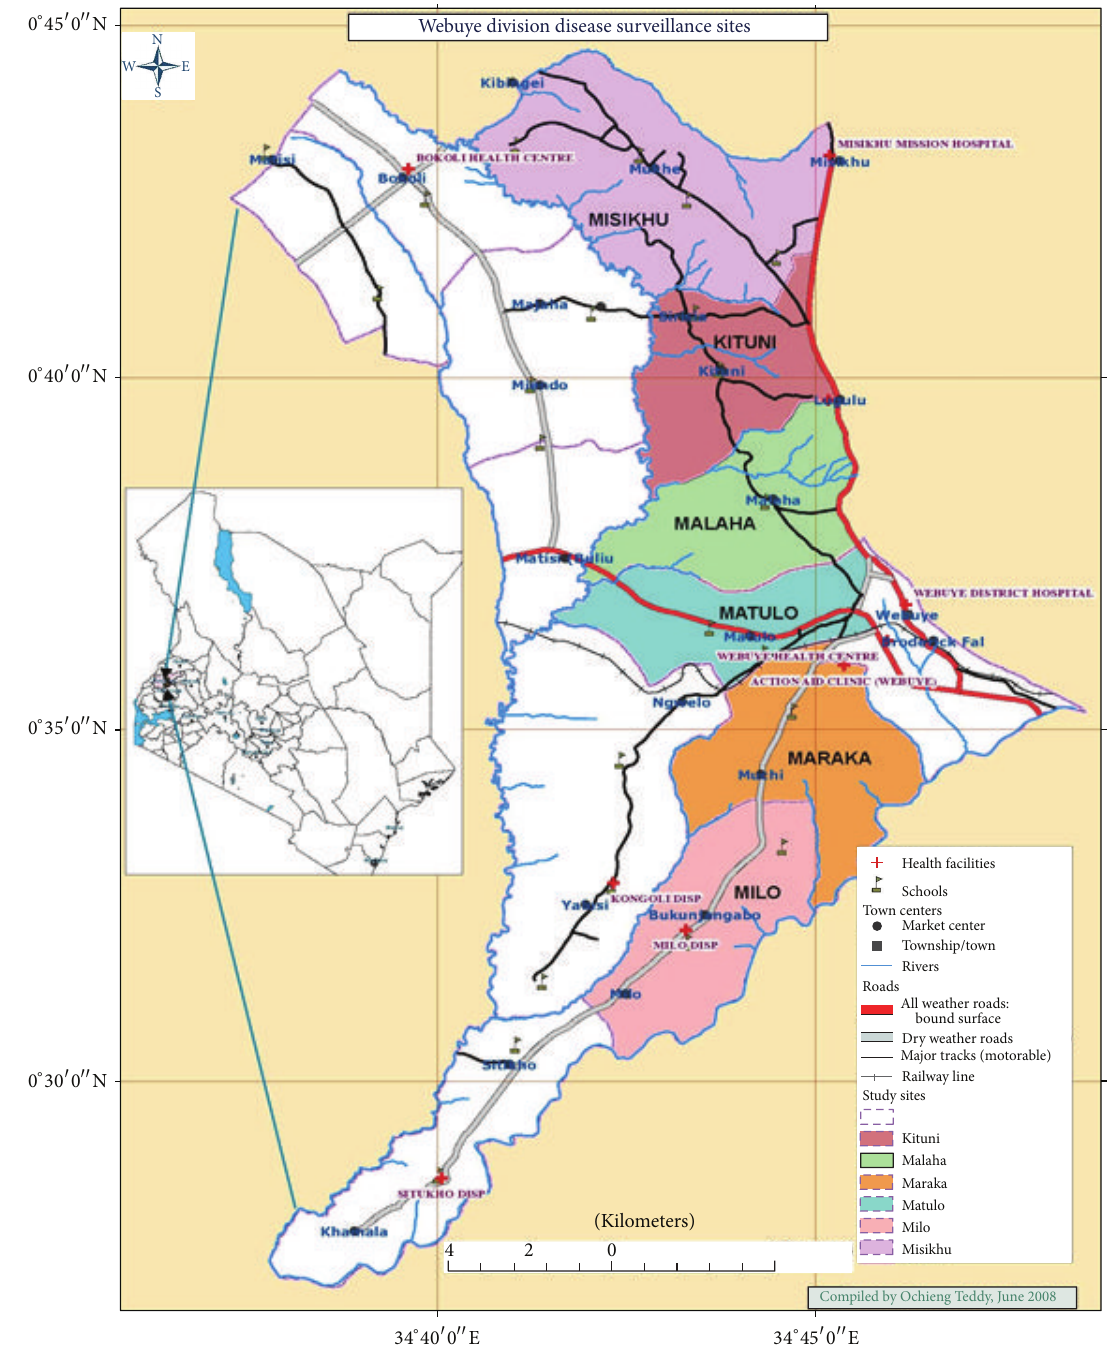
Figure 1: Webuye Health and Demographic Surveillance System